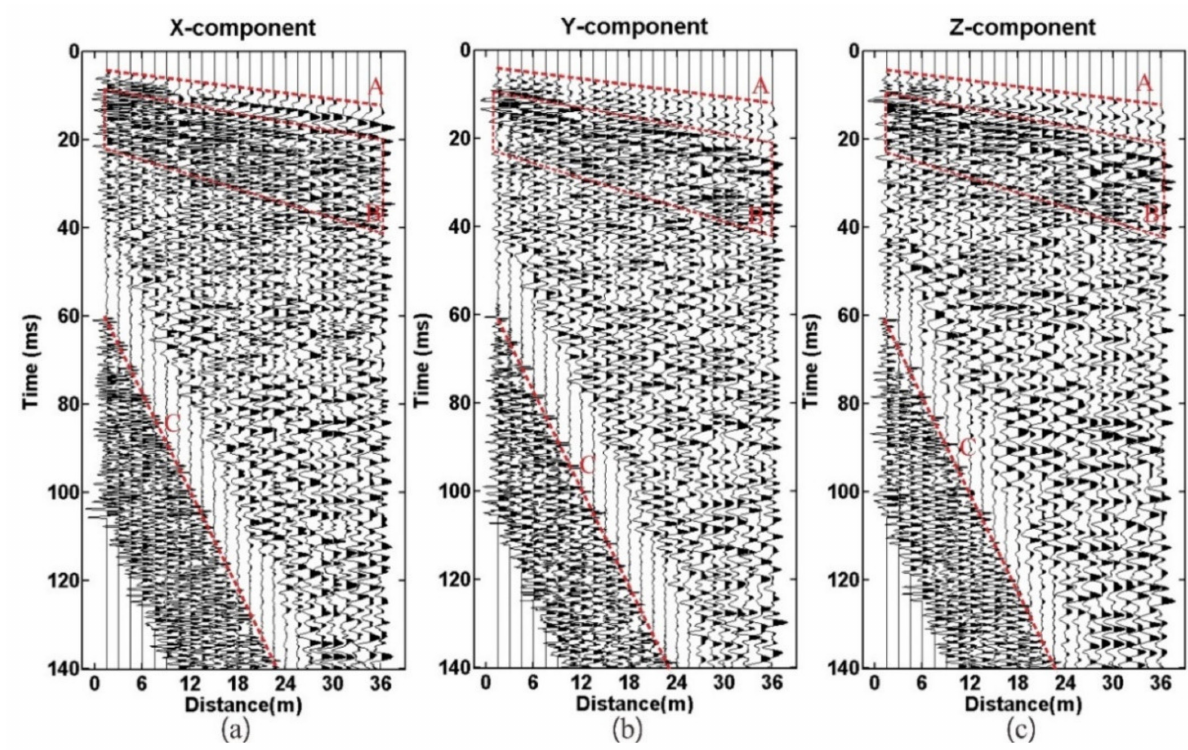
Figure 8. Geophone R-1: ( a ) X-component; ( b ) Y-component; ( c ) Z-component.